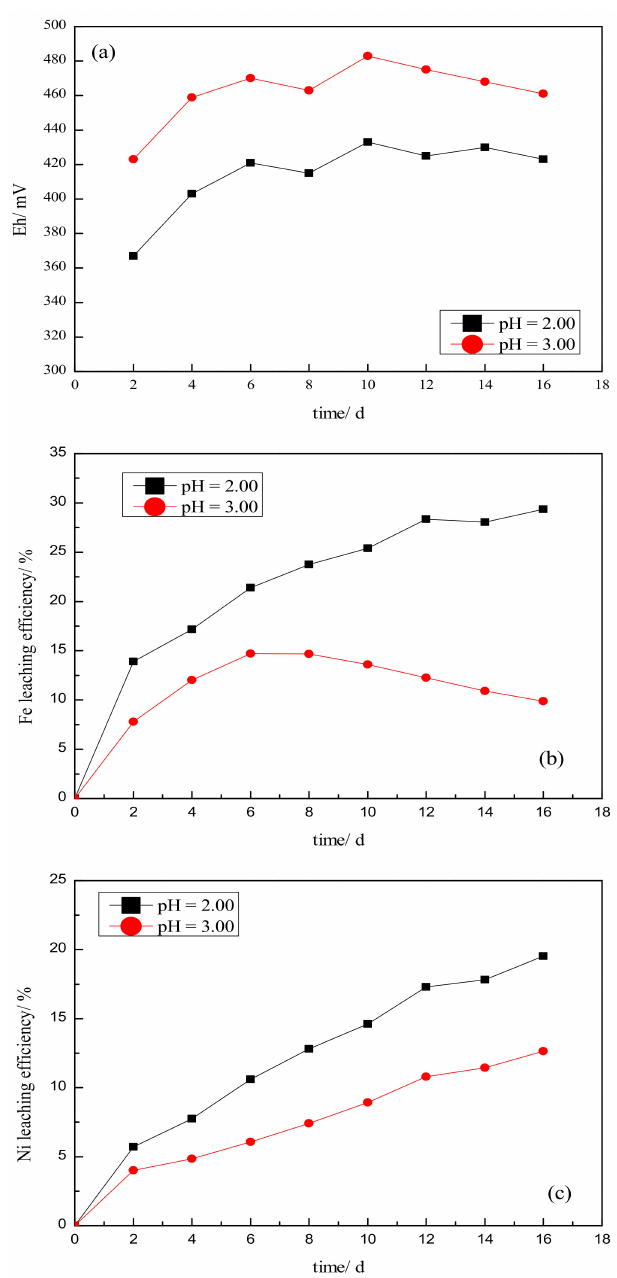
Figure 9. Changes in Eh ( a ), iron leaching e ffi ciency ( b ) and nickel leaching e ffi ciency ( c ) in solutions over